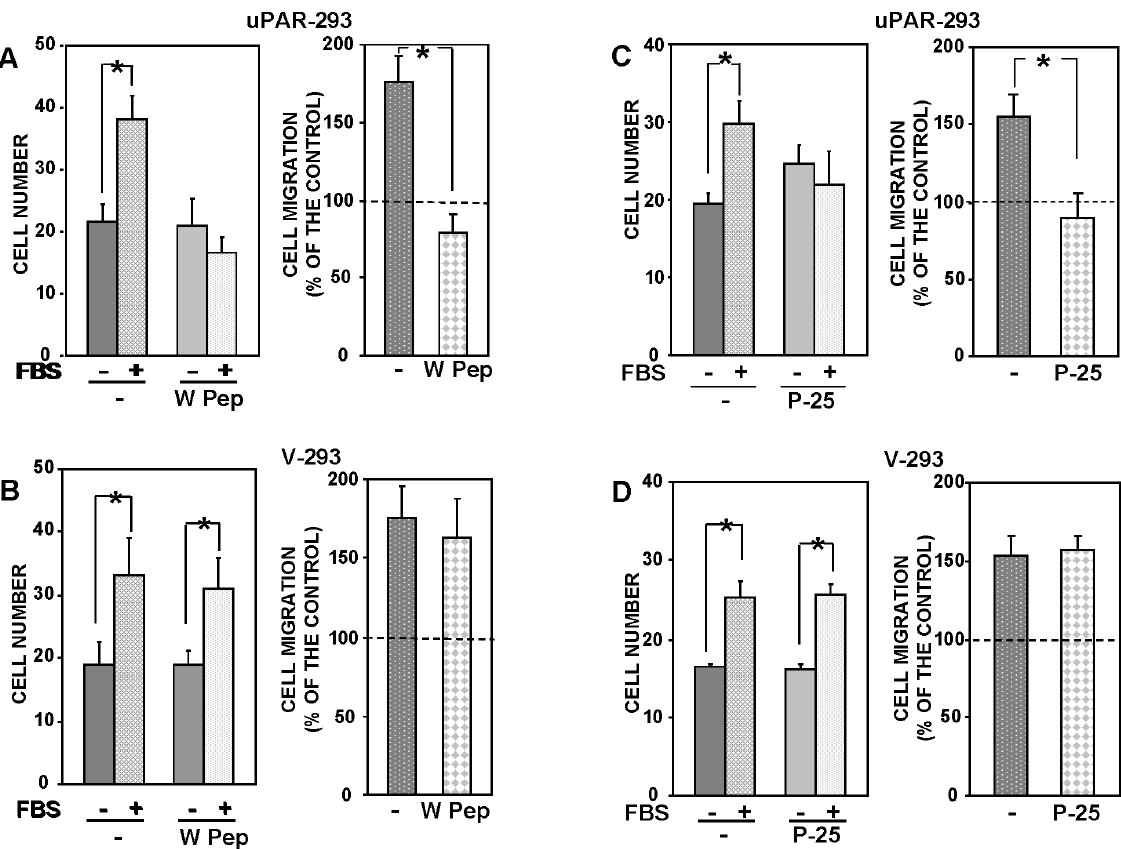
Figure 5. fMLF receptors and b 1 integrins are involved in uPAR capability to control cell migration. uPAR-293 cells ( A and C ) or V-293 cells ( B and D ) were pre-incubated with diluent (-) or W Peptide (W Pep) ( A and B ), or with diluent (-) or P-25 peptide ( C and D ). Cells were then plated in Boyden chambers and allowed to migrate toward 10% FBS. Migrated cells were fixed, stained with hematoxylin, and counted (left panels). The values are the mean 6 SD of three experiments performed in triplicate. (*) p # 0.05, as determined by the Student’s t test. Results of migration assays are also expressed as percentage of cells migrated towards serum over the cells migrated without serum; 100% values represent cell migration in the absence of chemoattractants (right panels). (*) p # 0.05, as determined by the Student’s t test.